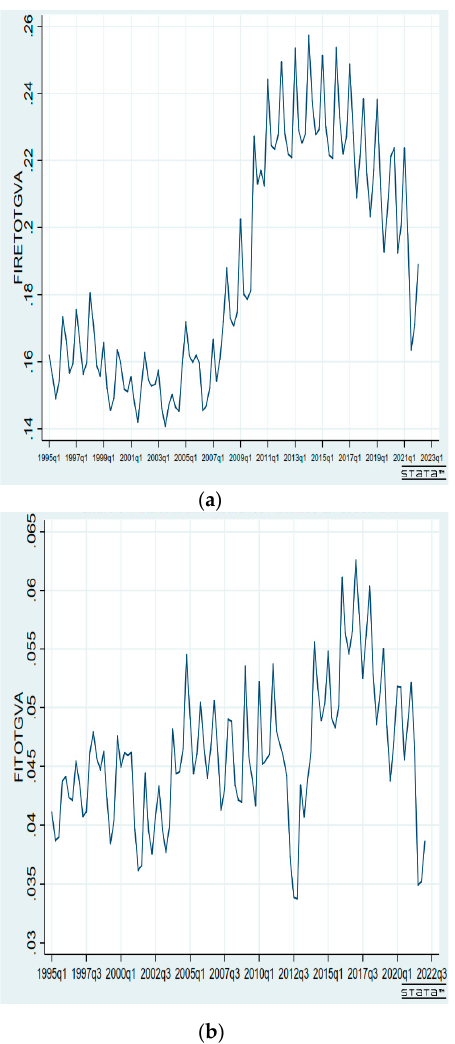
Figure A2. ( a ) Share of Financial, Insurance and Real Estate Activities to GVA to Greece. ( b ) Share of Financial and Insurance Activities on Greek GVA.